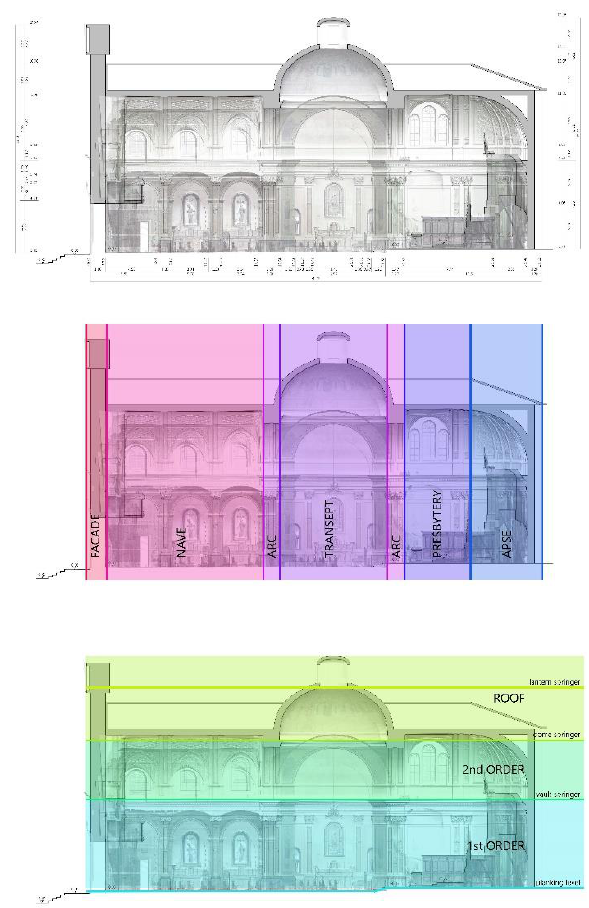
Figure 3 . Traditional technical drawings related to the semantic conceptual segmentation of the model according to the AAT thesaurus and historical